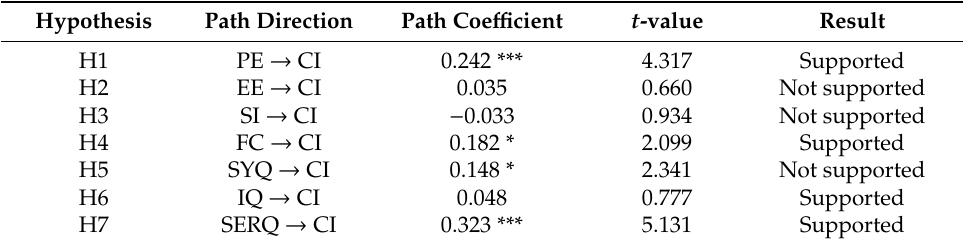
Table 5. Hypothesis testing